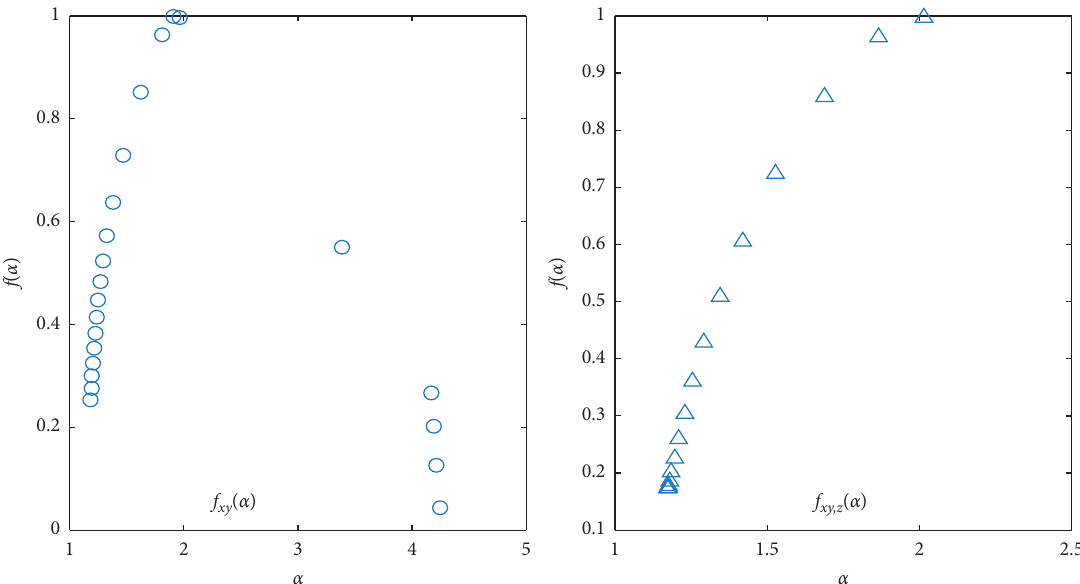
( α ) of bivariate time series obtained through MFDXA method and f xy